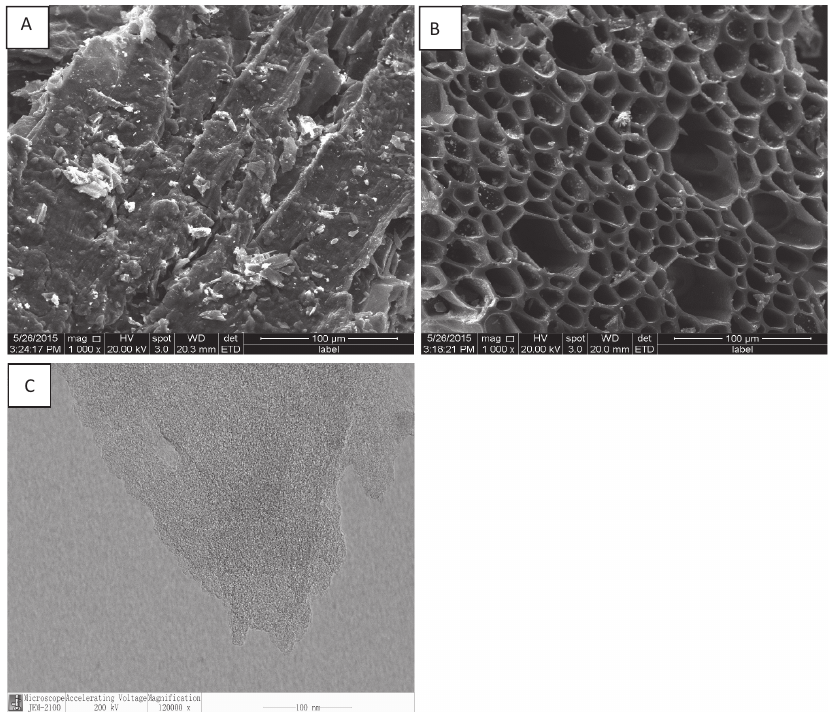
Figure 8: Scanning electron microscopy (SEM) images of char (a) and AC (b), TEM images of AC